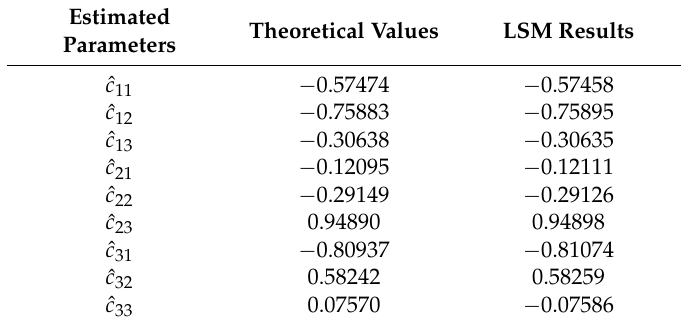
Table 3. Calibration results of LSM.